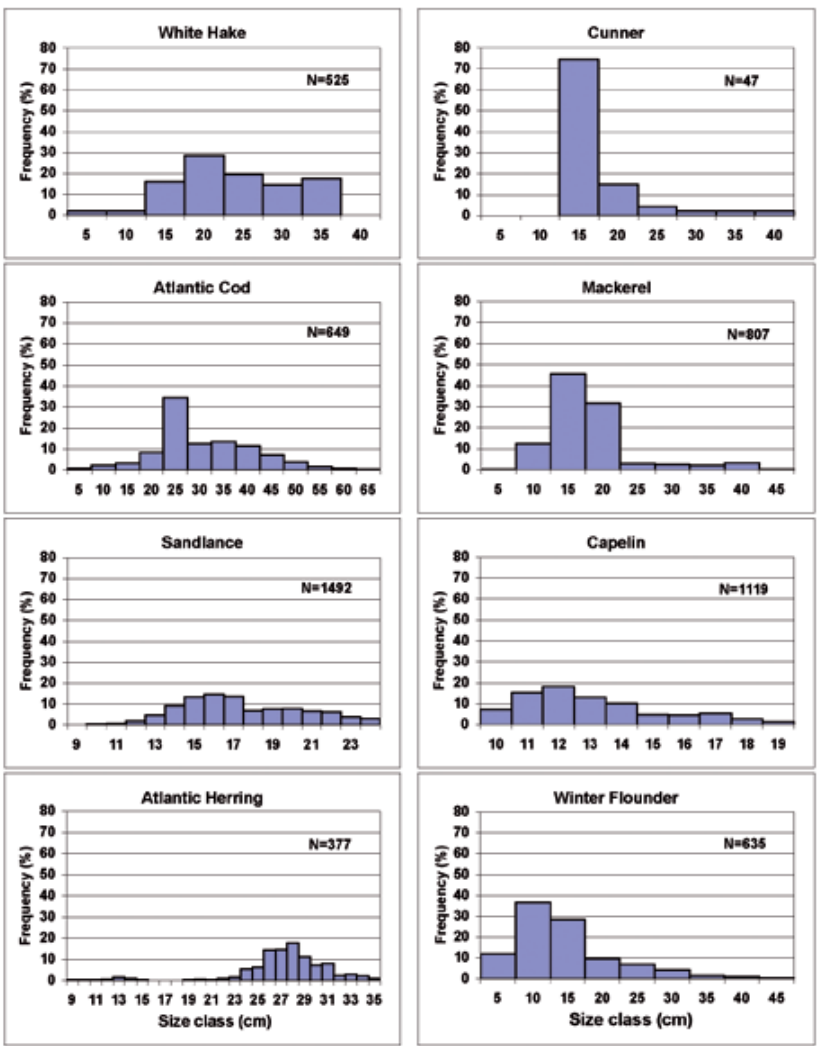
distribution (%) of es - timated lengths (cm) of prey consumed by grey seals in the Gulf of St. Lawrence and around Newfoundland between 1985 and